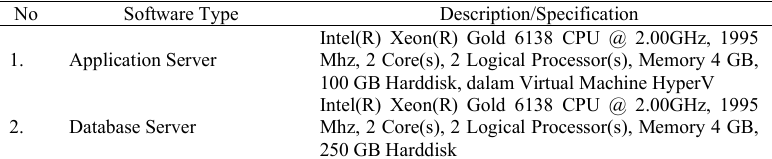
The Fig. 6 depicted that the software used in this study are categorized into 3 tiers, which are: Client Tier, Application Tier, and Database